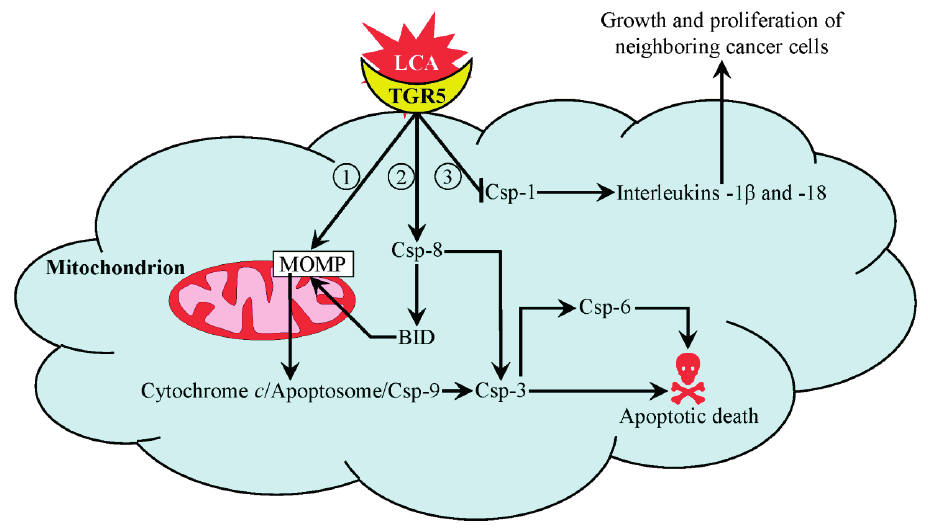
Figure 3. A mechanism underlying an anti-tumor effect of lithocholic acid (LCA) in cultured human neuroblastoma cells. LCA is the most potent natural agonist of TGR5, a plasma membrane-bound G protein-coupled receptor. LCA binding to TGR5 on the cell surface compromises viability and/or proliferation of human neuroblastoma cells by triggering three different pathways. The first pathway is initiated when LCA-stimulated TGR5 activates the cAMP/PKA signaling cascade. The ensuing specific changes in mitochondrial redox processes and morphology cause an activation of mitochondrial outer membrane permeabilization (MOMP), thus triggering the intrinsic (mitochondrial) pathway of apoptotic death. The second pathway leads to activation of the initiator caspase-8. Activated caspase-8 cleaves and stimulates both the executioner caspase-3 and BID (BH3-interacting domain death agonist), thus eliciting both the extrinsic (death receptor) and intrinsic (mitochondrial) pathways of apoptotic death, respectively. The third pathway operates via an inhibition of the inflammatory caspase-1, thus slowing down the processing and secretion of the cytokines interleukin-1 β and interleukin-18 and, ultimately, attenuating the growth and proliferation of neighboring neuroblastoma cells. See the text for additional details. Abbreviations: Csp-1, -3, -6, -8 and -9, caspases-1, -3, -6, -8 and